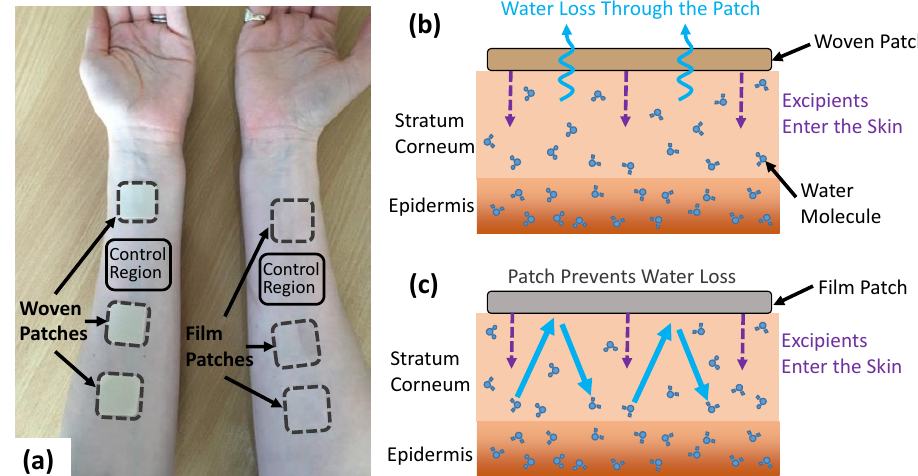
Figure 1. ( a ) The volar forearms of a subject with the woven- and film-backed patches applied with a control region left untreated on each arm. ( b , c ) show the mechanism by which the woven- and film-backed patches affect the movement of water in the skin.